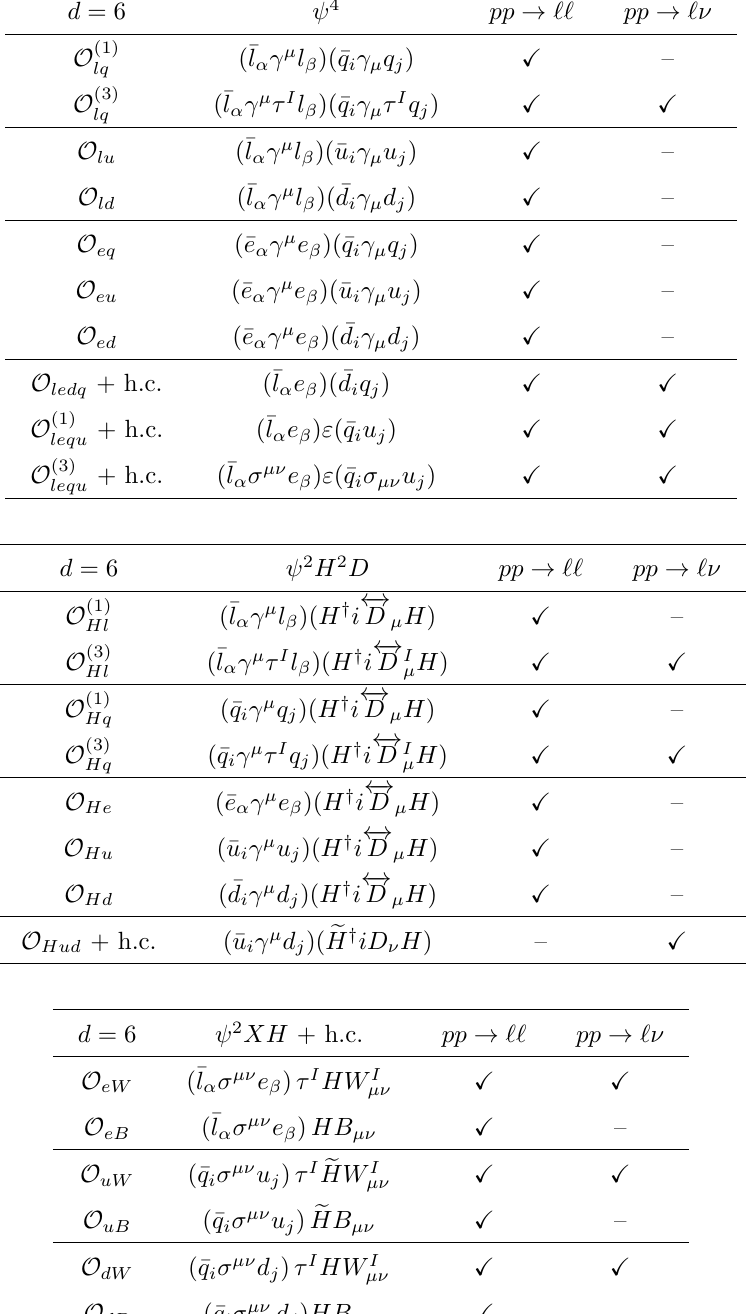
Table 6. SMEFT d = 6 operators that contribute to the processes pp → ‘‘ and pp → ‘ν . Semilep- tonic operators ( ψ 4 ) are collected in the upper table, whereas Higgs-current ( ψ 2 H 2 D ) and dipole operators ( ψ 2 XH ) appear in the middle and bottom tables, respectively. We use the operators in the Warsaw basis [43], where we renamed the operator O before quark-flavor